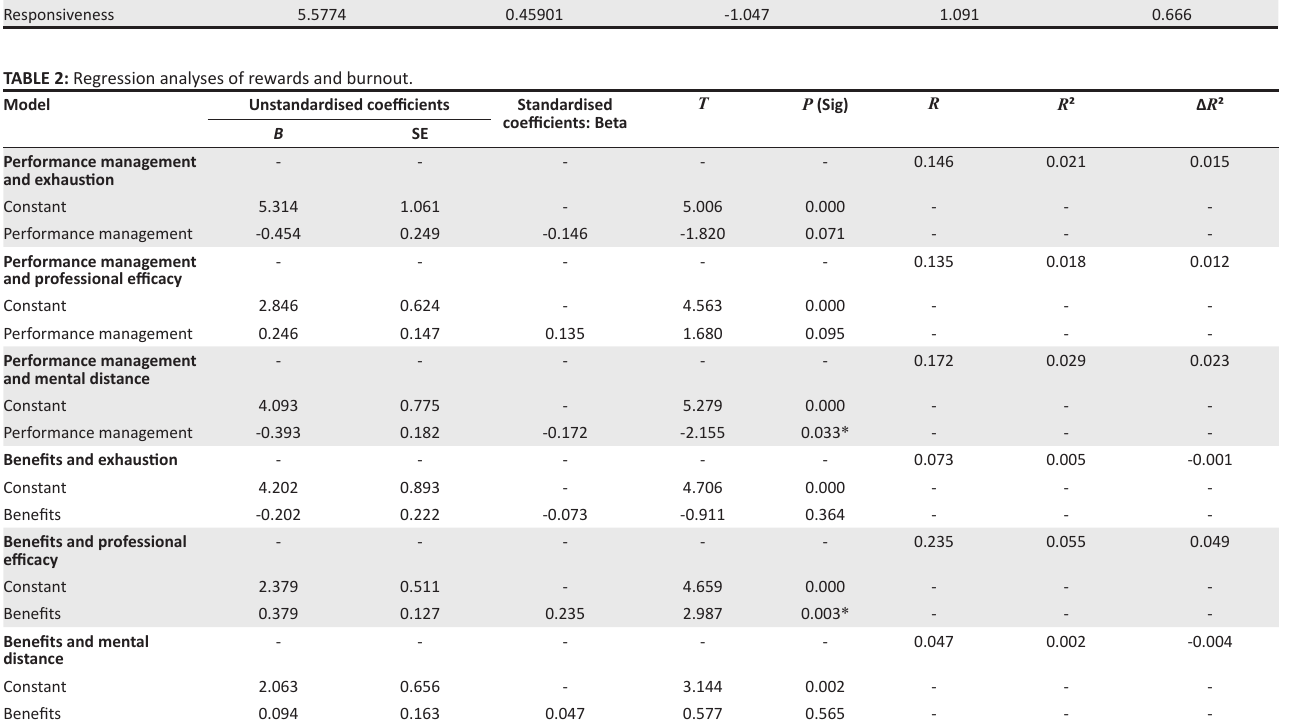
TABLE 2: Regression analyses of rewards and burnout.